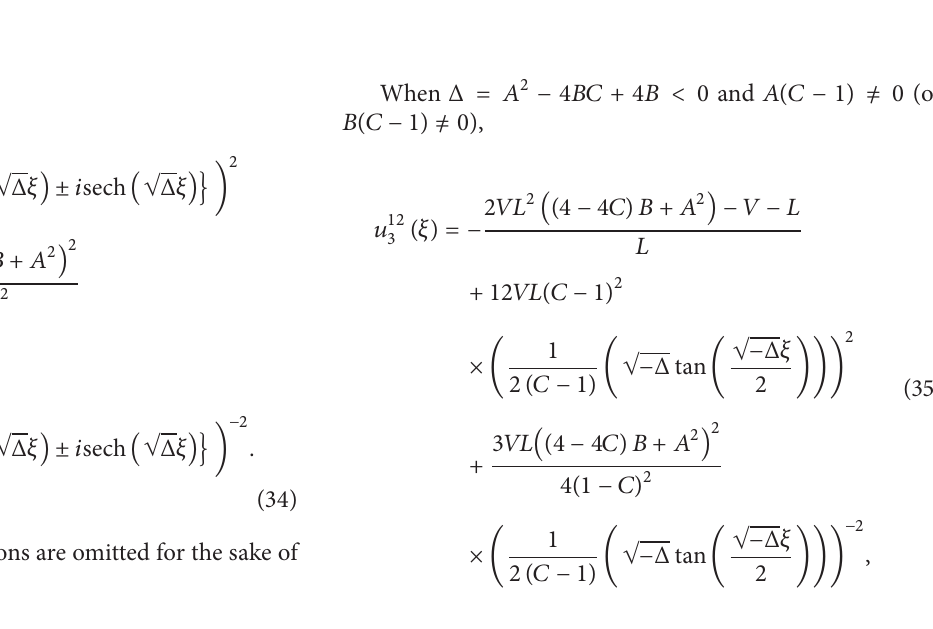
Figure 3: (a)–(d) show singular periodic traveling wave solution of 𝑢 12 2 for different values of